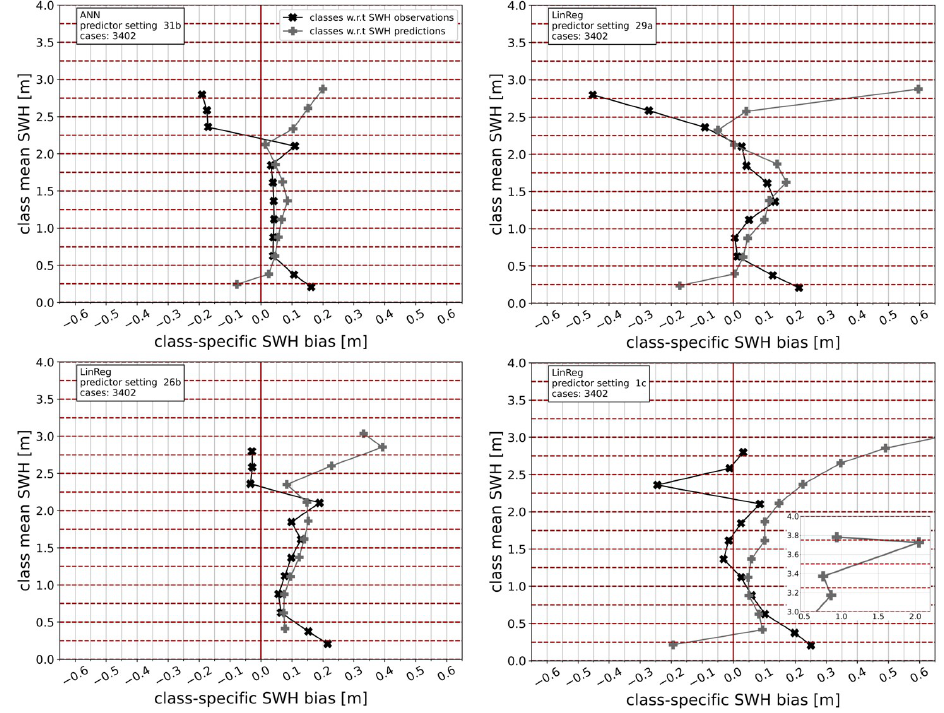
Figure 12. Conditional biases resulting from the whole testing dataset with the model predictions associated with scatter plots from Figure 10. The biases are conditioned on the observed SWH and the predicted SWH, respectively, as follows. The dataset consisting of pairs of predictions and associated observations is partitioned into classes according to the value of the observed (predicted) SWH. For each class, the conditional bias is displayed as a black (grey) cross with mean error of the respective class as abscissa and mean observed (predicted) SWH as ordinate. The partitioning into classes is made with an equidistant binning of the interval [ 0m,4m ) with a bin width of 0.25m (lower bin value inclusive, upper value exclusive). The boundaries of the bins are shown as red, dashed horizontal lines. Larger conditional biases of the benchmark model exceeding values of 0.5m and resulting from a vast overshooting of predictions are displayed in the lower-right pane with an additional inserted